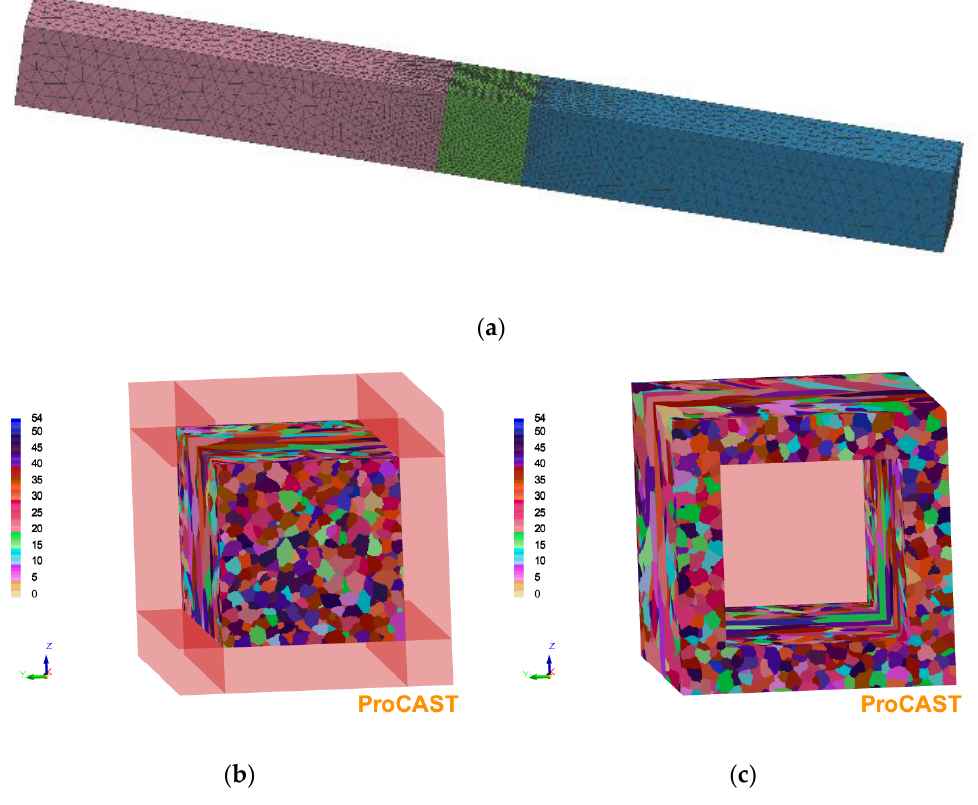
Figure 1. ( a ) An example of a model of a 20 mm thick plate (green) between two layers of 50 mm thick bentonite molding composition; ( b ) typical microstructure in the analyzed area with cross- section 10 × 10 mm; ( c ) 2.5 mm thick outer buffer layer. 10 × 10 mm; ( c ) 2.5 mm thick outer buffer